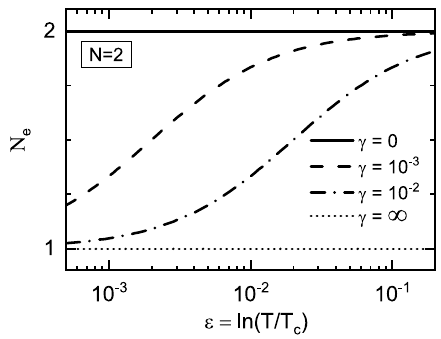
Fig. 5 Critical exponent x of c fl (and of − 𝜒 fl ∕ T and 𝜎 flAL ) for two- layer superconductors, as a function of 𝜀 and for different 𝛾 . The figure illustrates deviations from the 2D value ( x = 1 ) when 𝜀 and 𝛾 take comparable values, which may be further understood when contrasted with the N e evolution in Fig. 6